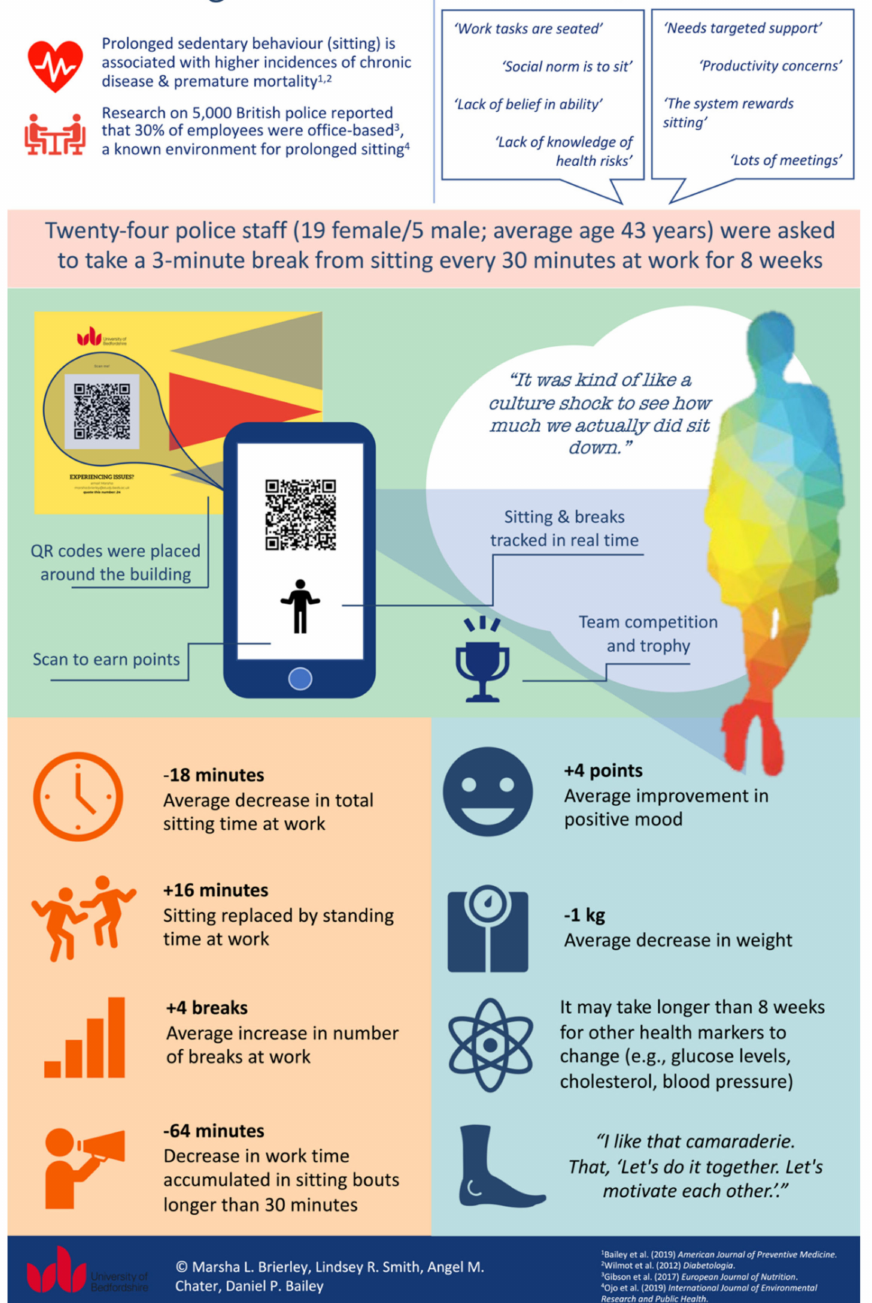
Figure 2. A-REST (Activity to Reduce Excessive Sitting Time) intervention infographic [3,5,12,46]. The A-REST intervention supported behaviour change with the following